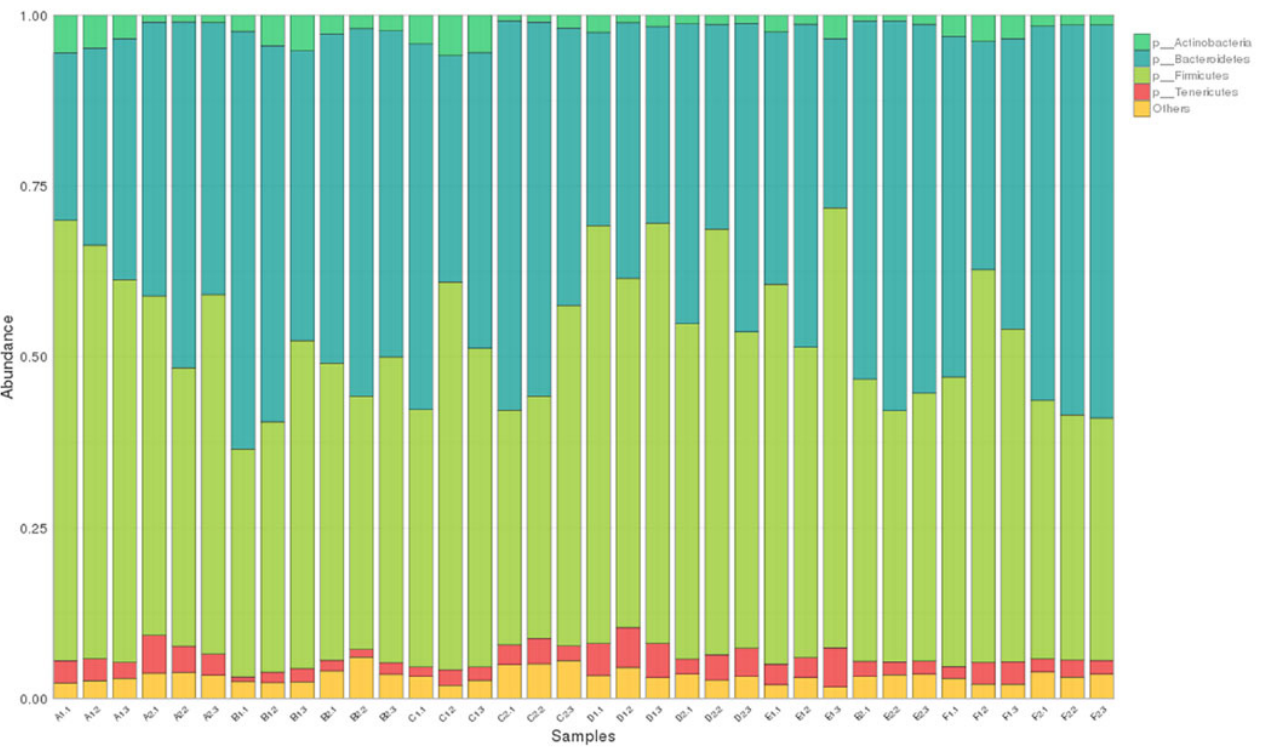
Figure 2. Distribution of the taxonomy stack of the microflora in the cecum of broiler chickens at the phylum level. The colored bar graph shows the distribution of the level of the bacterial phylum in the different treatment groups, and 1-1 to 1-3 represented the repetitions of the A1 group, which is the same as for other groups. Table 6. The relative abundance of dominant bacteria from different groups on day 28.